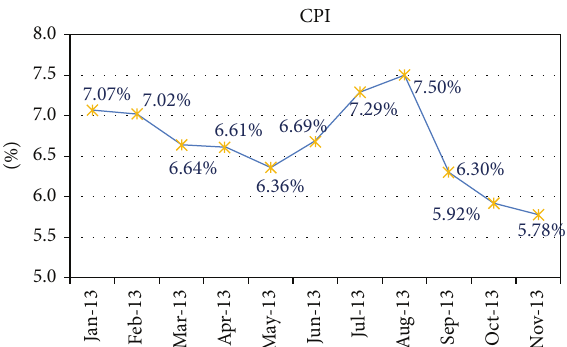
Figure 2: The Vietnamese CPI from January to November,